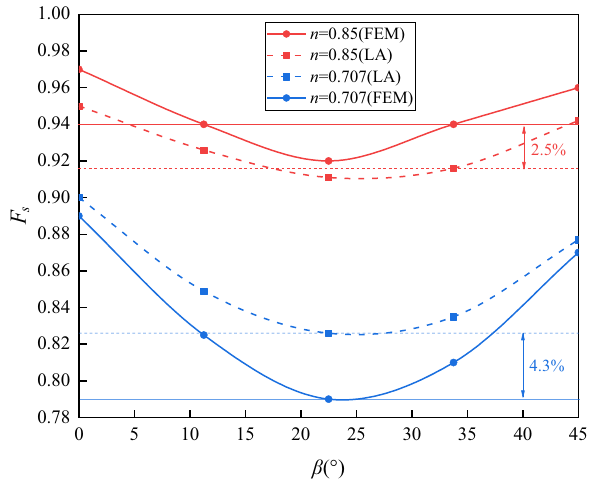
Figure 11. Factor of safety of slopes against the anisotropic parameter β